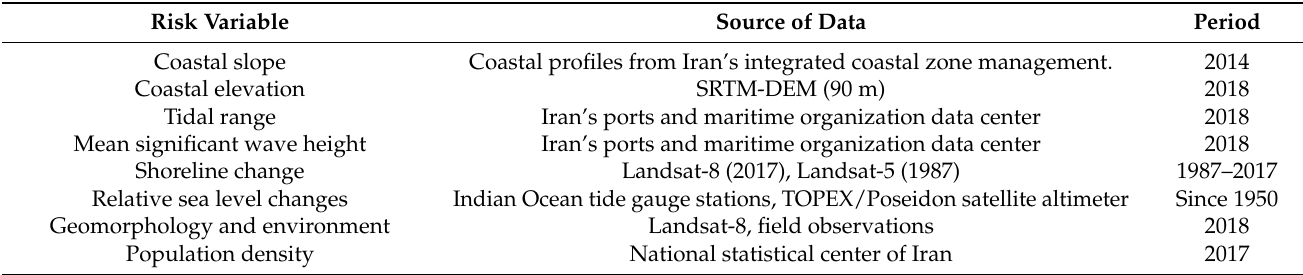
Table 1. Risk variables and data sources used to calculate the Coastal Vulnerability Index. Risk Variable Source of Data Period Coastal slope Coastal profiles from Iran’s integrated coastal zone